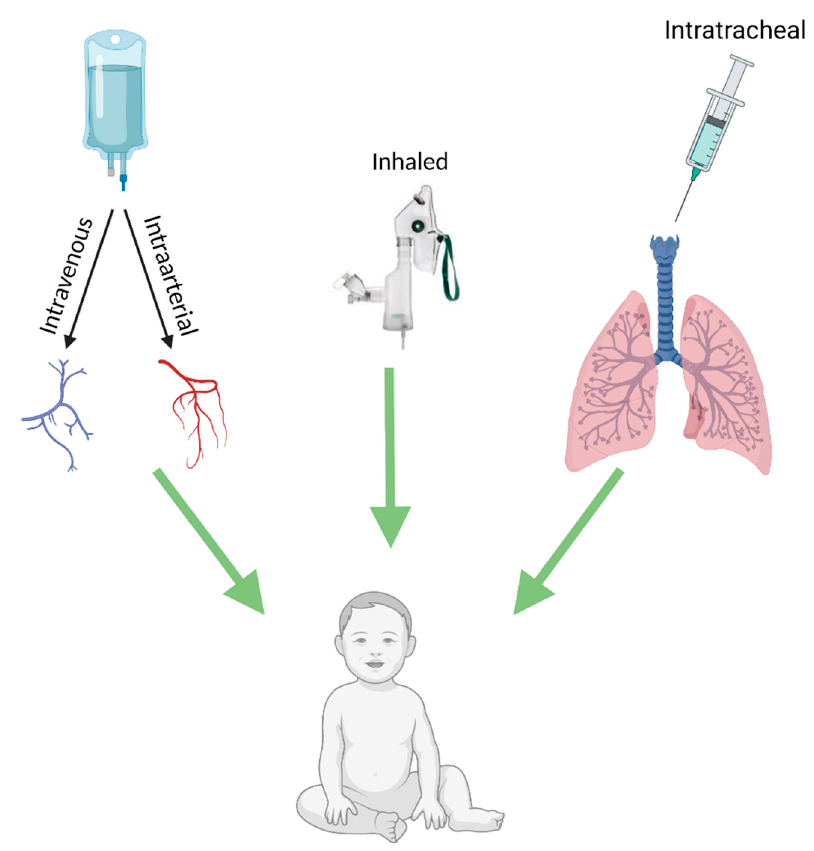
Figure 1. Potential routes of delivery for cell therapies to paediatric patients. Adapted from [23]. Created with BioRender.com (accessed on 21 July 2021) .